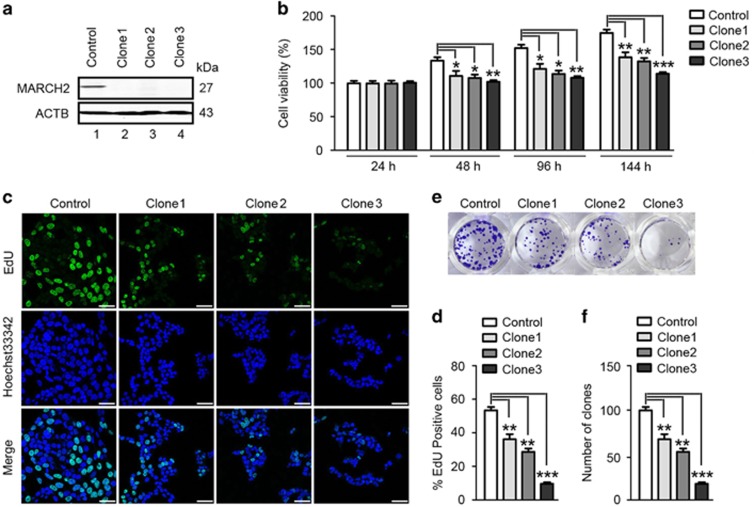
Knockout of MARCH2 suppresses colon cancer cell growth. (a) Western blot analysis of MARCH2 protein expression in Cas9-MARCH2 HCT116 cells. (b) MTS cell viability assay. Control (wild-type) and Cas9-MARCH2 HCT116 cells were seeded in 96-well plates (3000 cells/well; five replicates), serum-starved for 18 h and then pulsed with 10% FCS for 24 h, 48 h, 96 h or 144 h. Data are mean±S.D. of three independent experiments. (c) Representative confocal microscopy of immunofluorescent staining for EdU. Control and Cas9-MARCH2 HCT116 cells were plated on glass slides in 24-well plates, serum-starved for 18 h, pulsed with 10% FCS for 48 h and incubated with EdU for 4 h. Nuclei were stained with Hoechst 33342. Scale bar: 100 mm. (d) Quantification of the percentage of EdU-positive cells (in 200 cells). Each bar represents the mean±S.D. of three independent experiments. (e) Representative images of colony formation by control (wild-type) cells and Cas9-MARCH2 HCT116 cells. (f) Quantitative analysis of colony numbers for three independent experiments. *P<0.05, **P<0.01, ***P<0.001